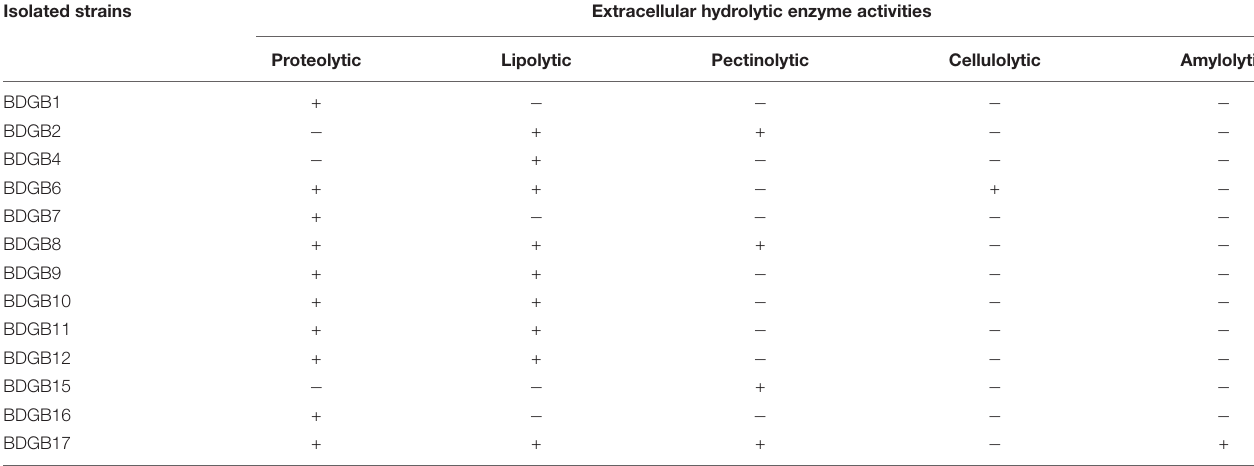
TABLE 1 | Hydrolytic enzyme profile of the gut-associated bacteria of Bombay duck. Isolated strains Extracellular hydrolytic enzyme activities Proteolytic Lipolytic Pectinolytic Cellulolytic